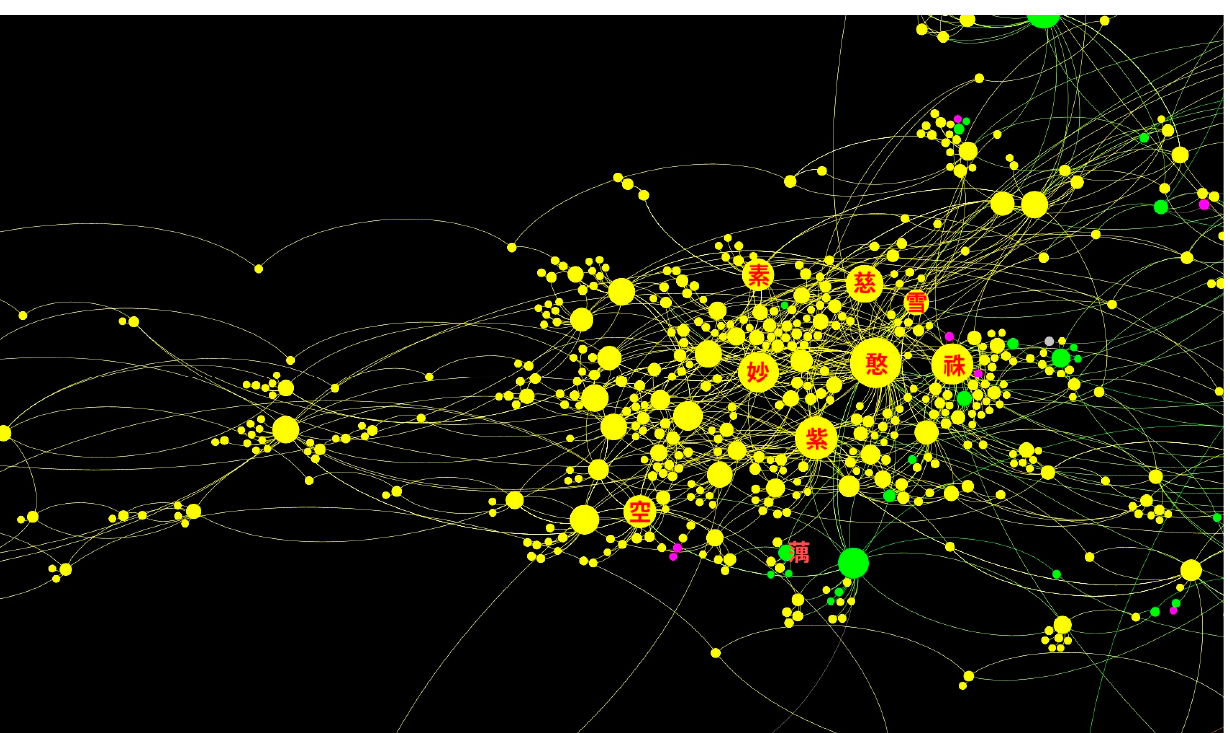
Figure 2. The “Wanli Revival” stage: a dense cluster of famous “great monks” ( 憨山德清 Hanshan Figure2. The“WanliRevival”stage: a dense cluster of famous “great monks” ( 憨憨憨山德清 HanshanDe‑ Deqing (A001681 16 ), 雲棲祩宏 Yunqi Zhuhong (A001394), 紫柏真可 Zibo Zhenke (A000944), 蕅益智 qing (A001681 16 ), 雲棲祩祩祩宏 Yunqi Zhuhong (A001394), 紫紫紫柏真可 Zibo Zhenke (A000944), 蕅蕅蕅益智旭 旭 Ouyi Zhixu (A001257), 妙峰褔登 Miaofeng Fudeng (A007760), 素庵真節 Su’an Zhenjie (A008316), Ouyi Zhixu (A001257), 妙妙妙峰褔登 Miaofeng Fudeng (A007760), 素素素庵真節 Su’an Zhenjie (A008316), 雪浪洪恩 Xuelang Hong’en (A004672), 空印鎮澄 Kongyin Zhencheng (A001889)), and an important 雪雪雪浪洪恩 Xuelang Hong’en (A004672), 空空空印鎮澄 Kongyin Zhencheng (A001889)), and an important patron ( 慈聖太后 the Empress Dowager Cisheng (A007207)). patron ( 慈慈慈聖太后 the Empress Dowager Cisheng